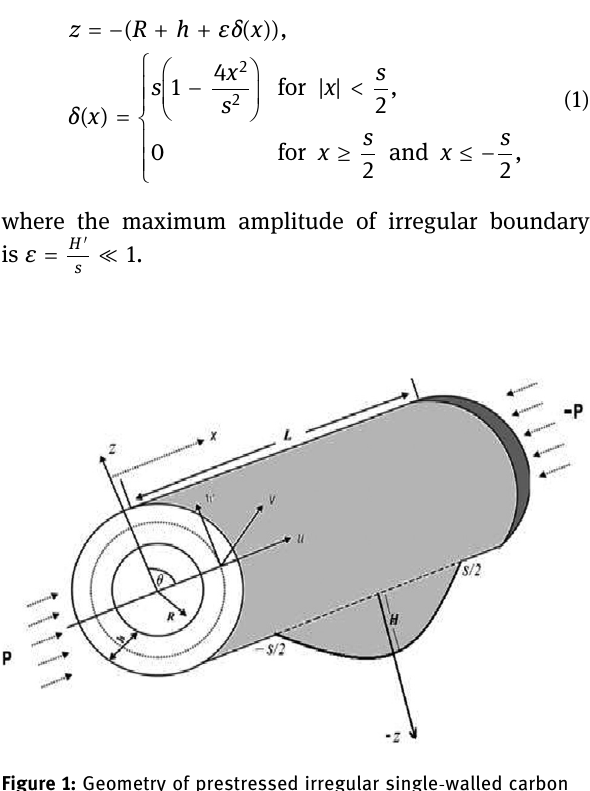
Figure 1: Geometry of prestressed irregular single - walled carbon